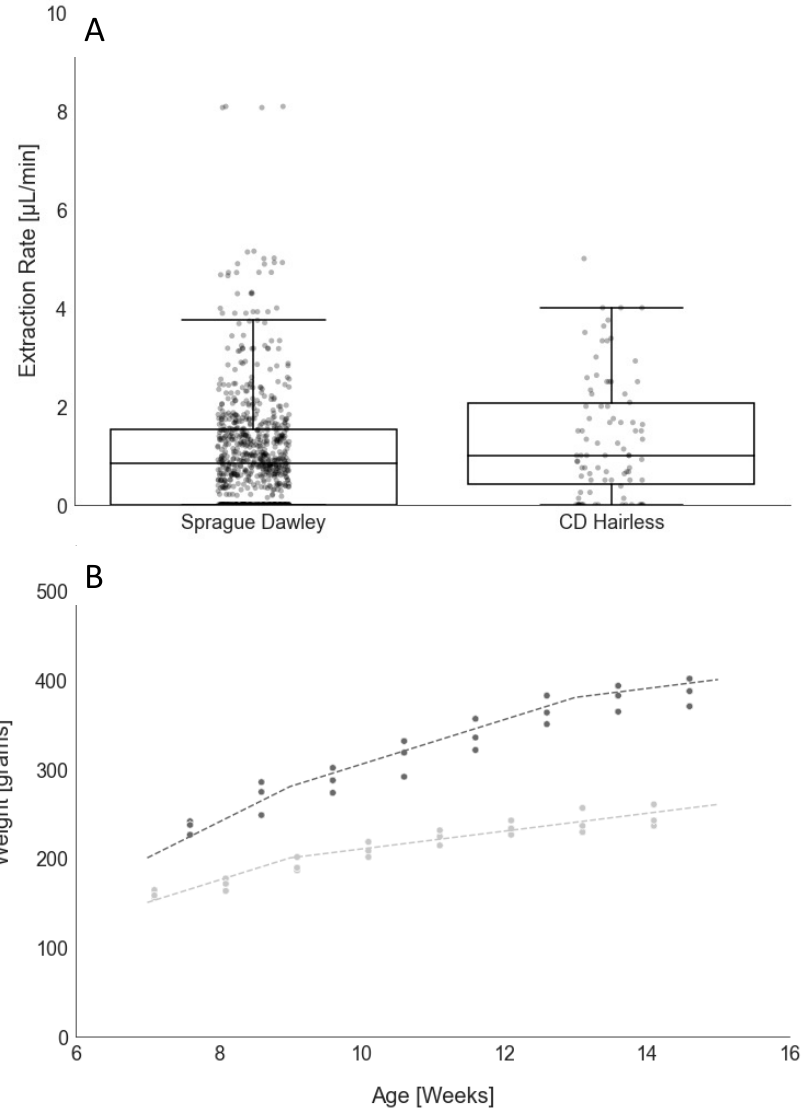
Figure 2. ISF Extractions in CD ® Hairless and Sprague Dawley Rats. ( A ) Extraction rate ( μ L/min) is shown for each individual microneedle array application for the CD ® Hairless (N = 3, n = 41) and Sprague Dawley (N = 6, n = 208) rats on the dot plots. N = number of animals, and n = number of MA applications. An underlay boxplot is shown representing the extraction rate quartiles. ( B ) Growth rates for the female (light gray) and male (dark gray) Sprague Dawley rats included in the longitudinal study. Dashed lines show representative data extrapolated from growth charts from the supplier [25].